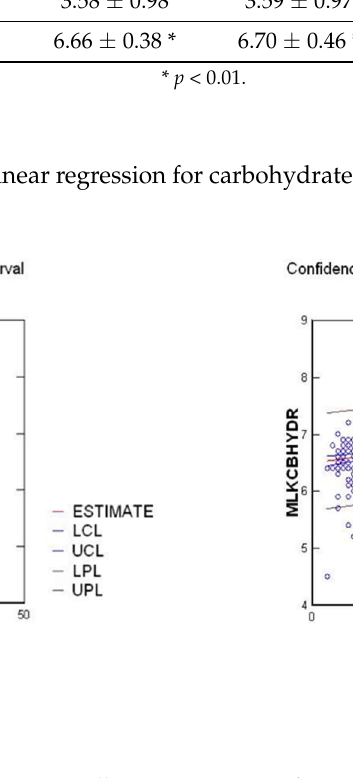
Figure 2. Linear regression between milk composition in g/100 mL and postnatal age (PNA) in days, for: ( a ) Protein milk content (MLKPROT); ( b ) Carbohydrate milk content (MLKCBHYD).